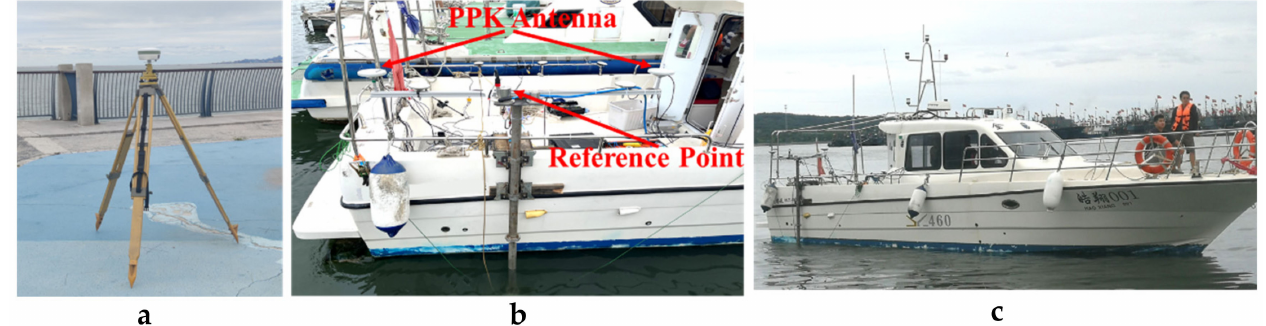
Figure 7. Experimental equipment. ( a ) The HI TARGET A8 Plus receiver on the shore; ( b ) Two Trimble receivers and an IMU mounted on the ship’s side; ( c ) Survey